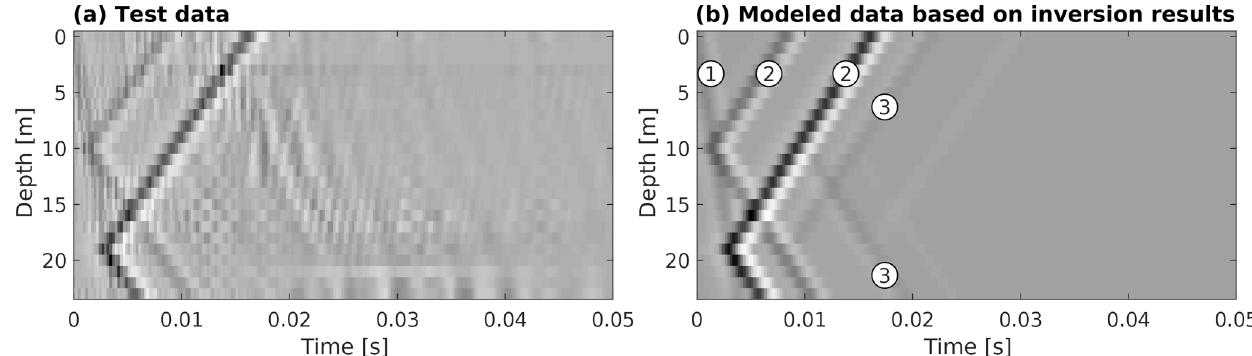
Figure 1. (a) Synthetic test data featuring two fractures at 10 and 19m depth contaminated with ambient noise from observed hydrophone VSP data acquired at the underground Grimsel Test Site in Switzerland; (b) simulated data based on an inferred model at the end of a Markov chain. (1) denotes the direct P wave, (2) the tube waves generated at the fractures, and (3) the tube waves reflected at the fractures.